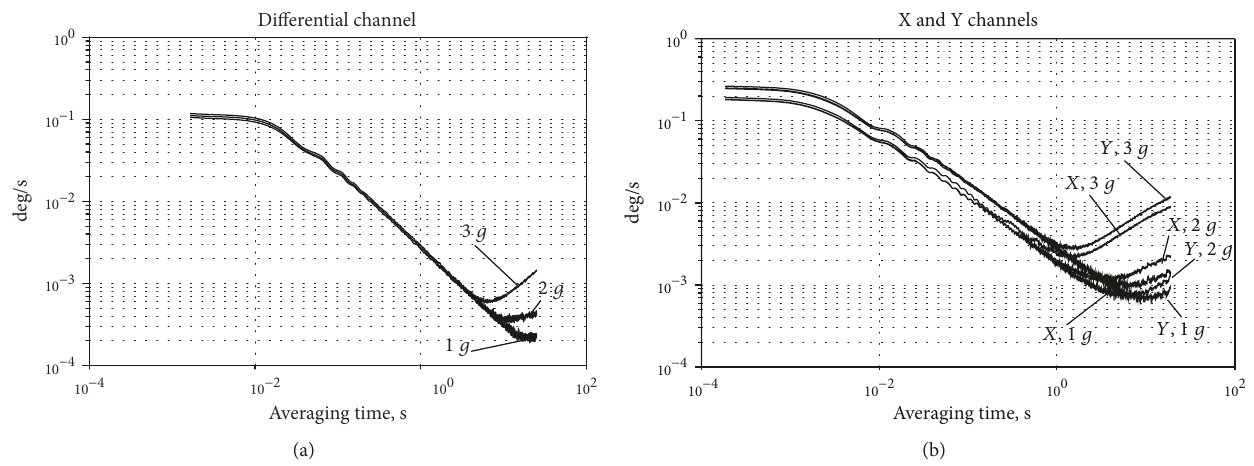
Figure 11: Di ff erential CVG signal root of Allan variances at vibration frequency 100 Hz.